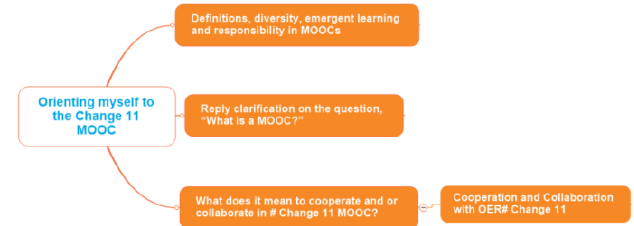
Figure 6. Topic generated base on the “orientation myself in MOOCs” post